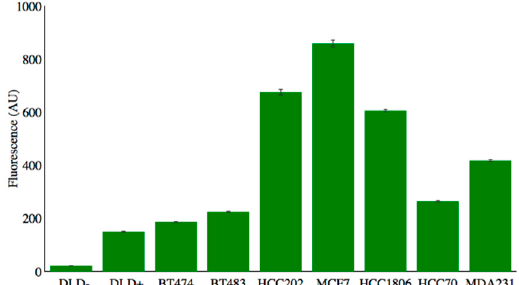
Figure 2. FACS data showing the binding efficiency of fluorescently labeled CD47 antibodies to various cell lines.